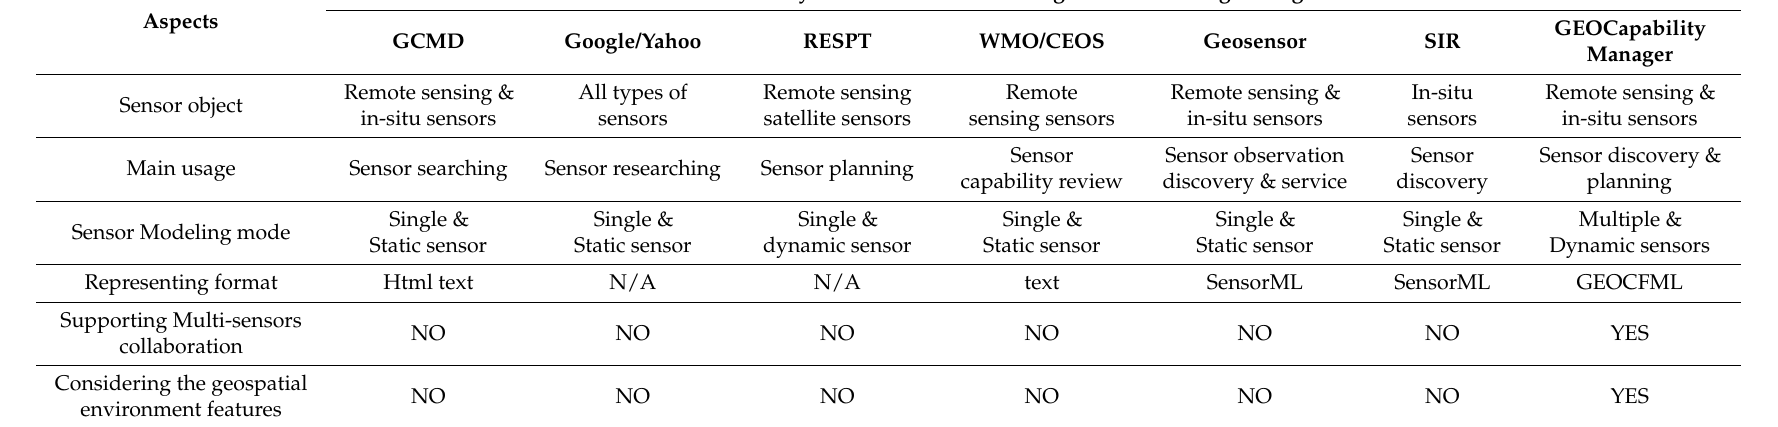
Table 3. Comparison between existing sensor management systems and